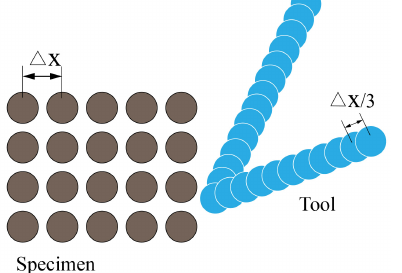
Figure 3. Diagrammatic drawing of the PD cutting model.